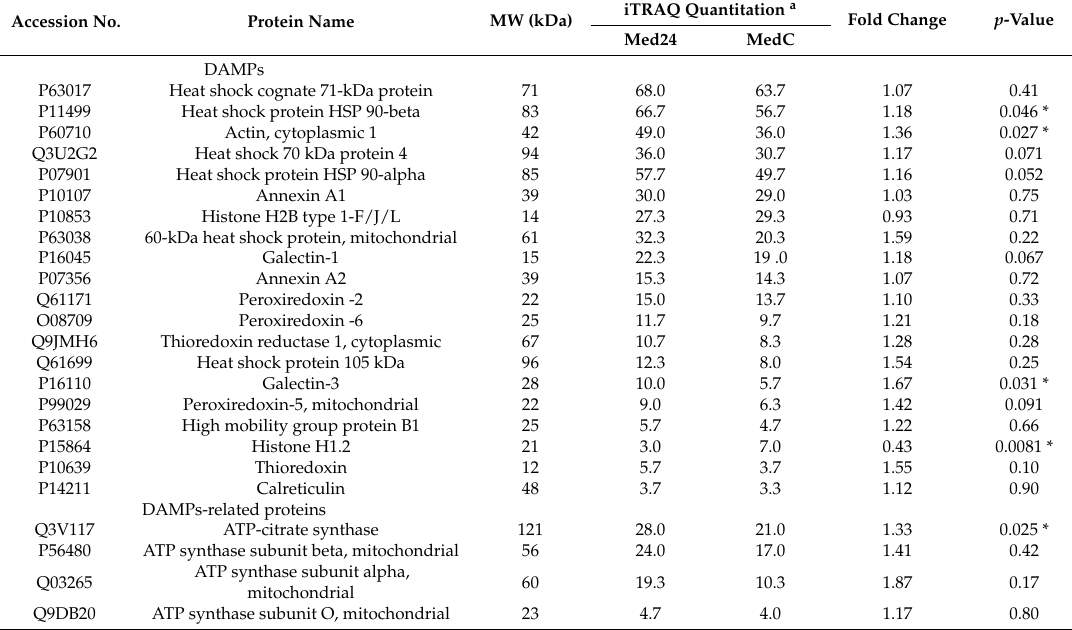
Table 3. DAMPs and DAMPs-related proteins in secretomes. a Mean of three assessments. * p <